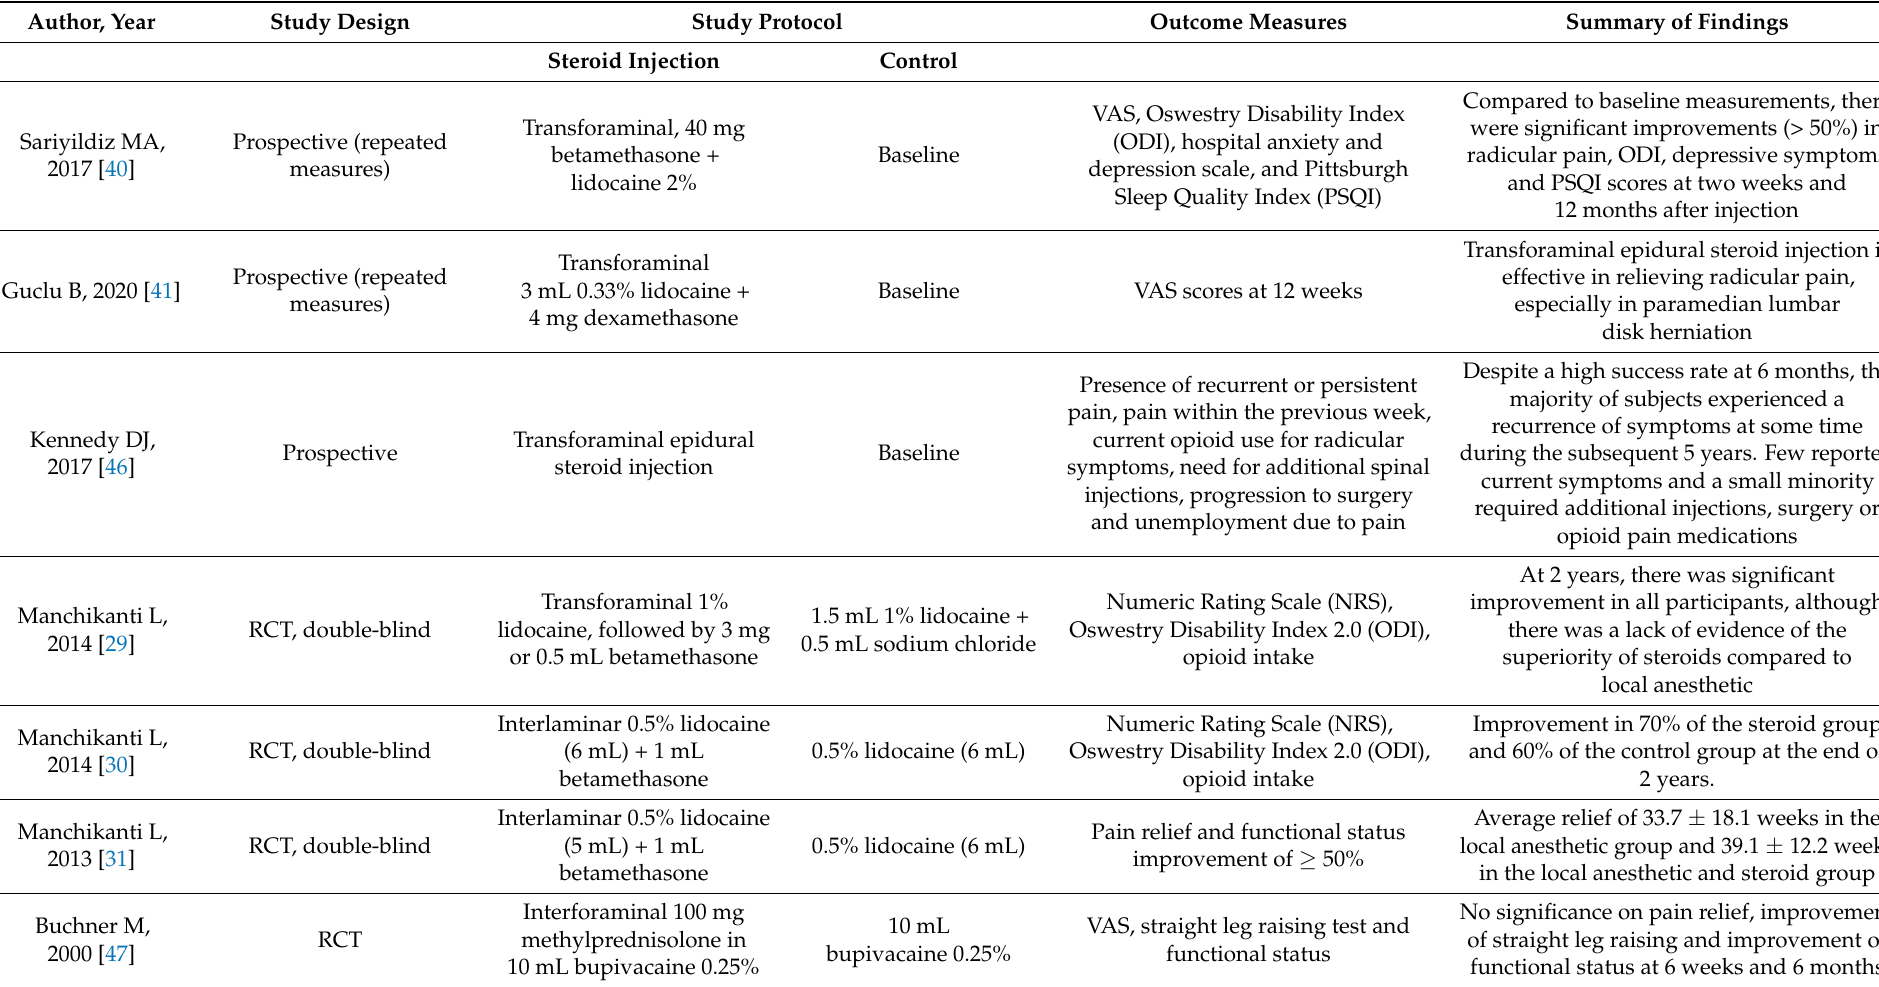
Table 1. Epidural steroid injections for disk herniation